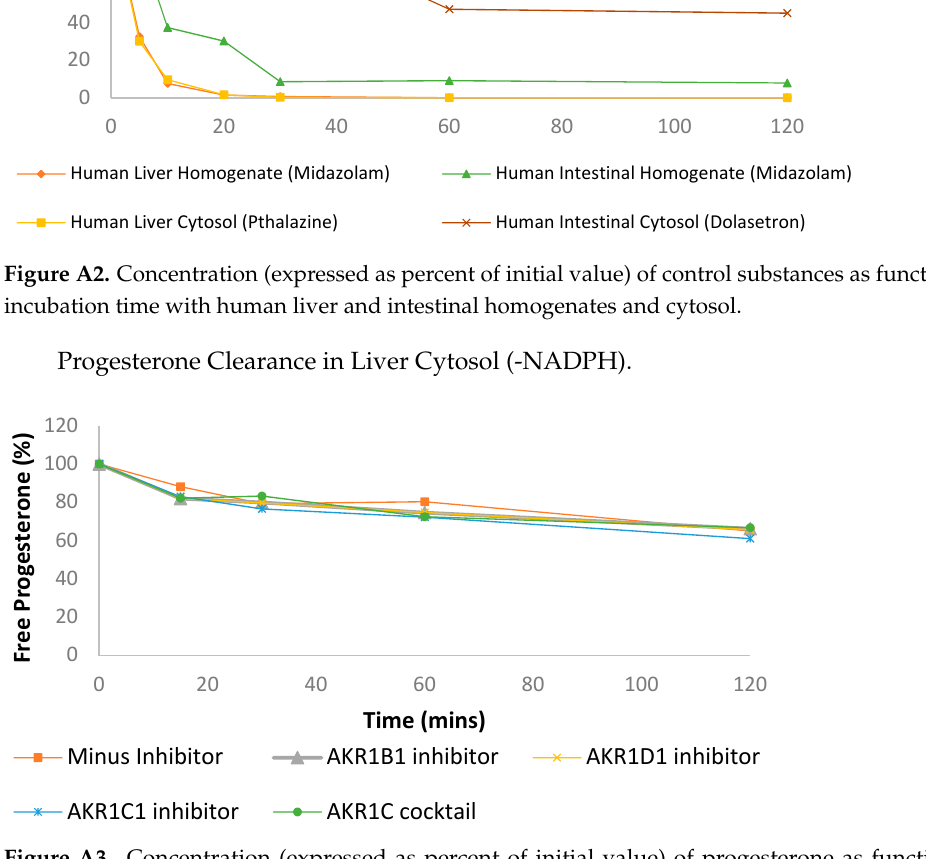
Figure A4 . Concentration (expressed as percent of initial value) of progesterone as func- tion of incubation time with human liver cytosol and enzyme inhibitors, as indicated. References 1.